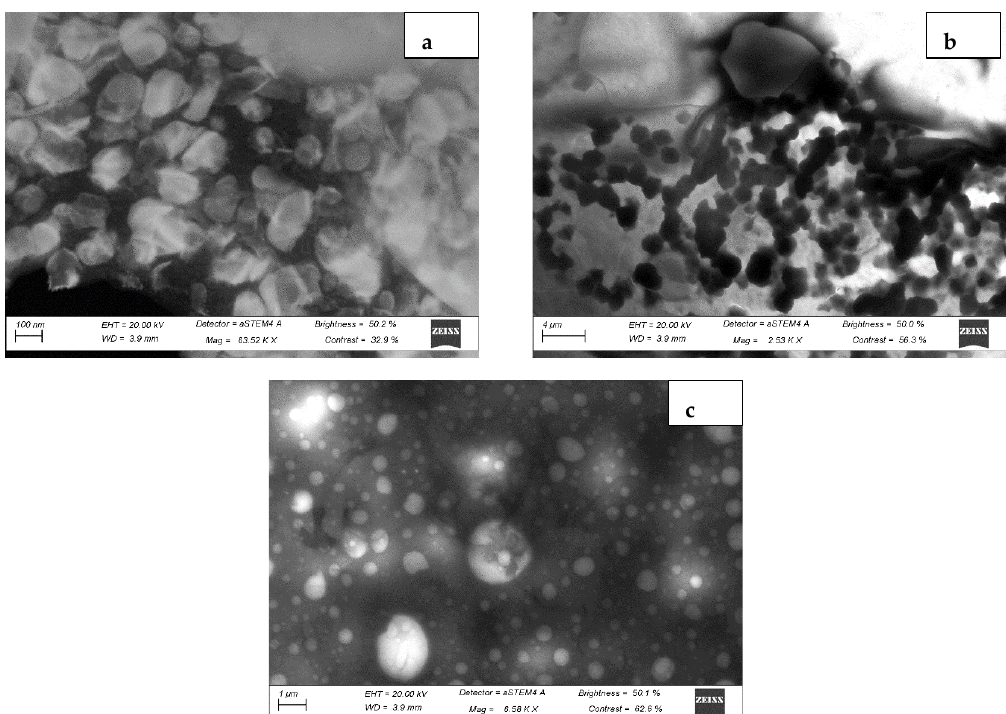
Figure 5. Scanning Transmission Electron Micrograph of Bambara groundnut– Moringa oleifera bars (BAMOnut). ( a ) Morphology of BAMOnut enriched with oats and 3% BAMOLP on 100 nm scale, ( b ) BAMOnut enriched with millet and 2% BAMOLP on 4 µm scale, ( c ) BAMOnut enriched with oats, millet and 5% BAMOLP on 1 µm scale (magnification 63.52 KX for ( a ), ( b ): 2.53KX, ( c ): 6.58KX). Table 5. Water activity of Bambara groundnut– Moringa oleifera snack bars.